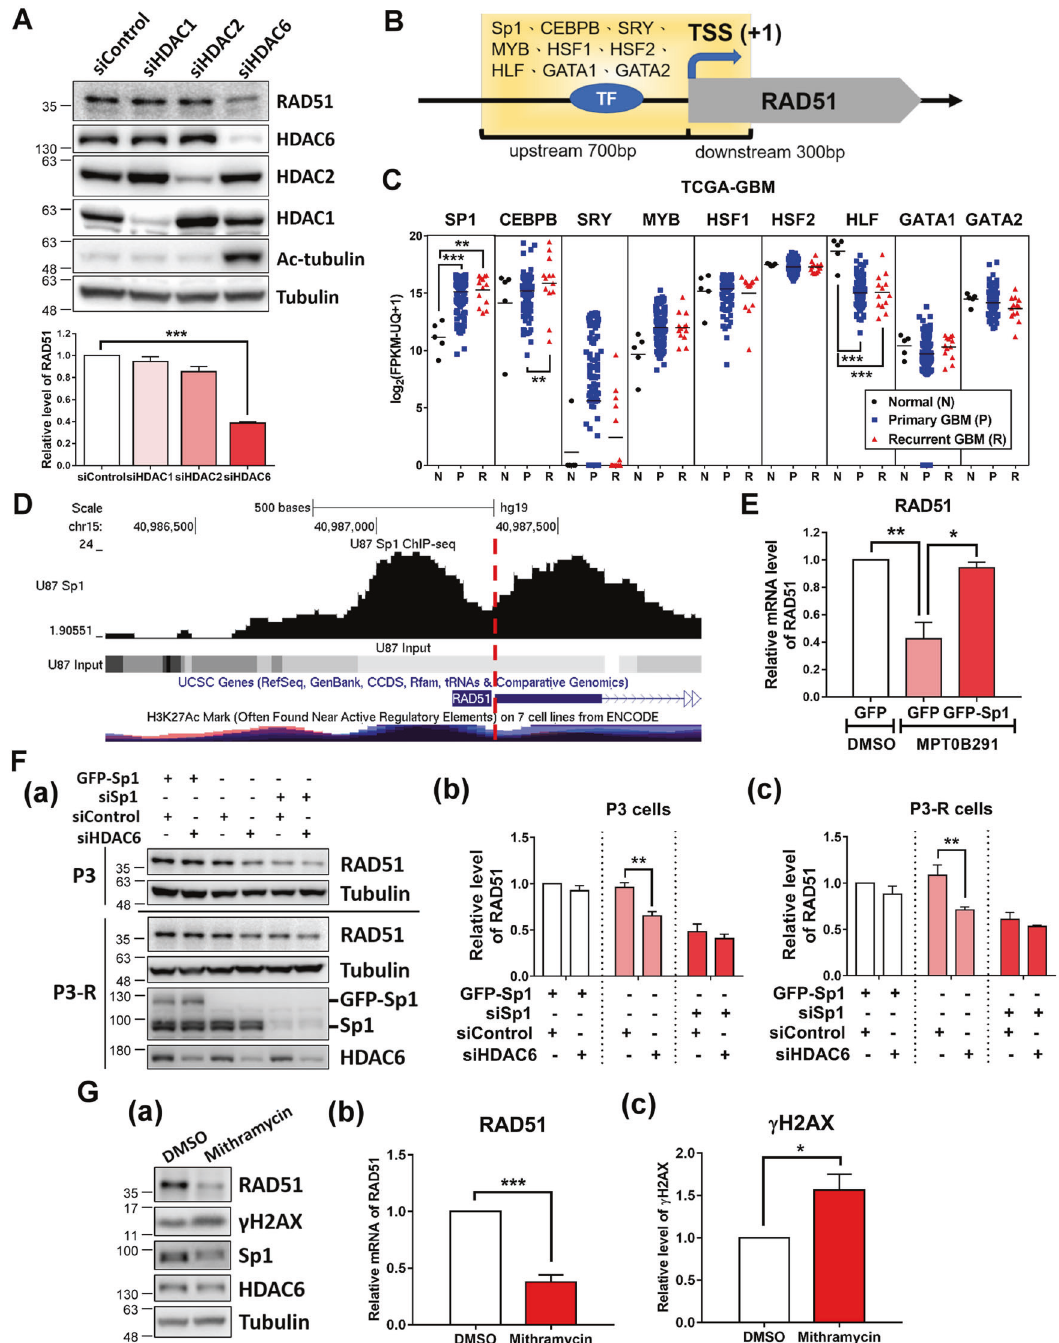
Fig. 5 HDAC6 regulates RAD51 expression through Sp1. A U87MG cells were transfected with control, HDAC1, HDAC2, and HDAC6 siRNA, respectively, for 72 h. The protein levels of RAD51, HDAC1, HDAC2, HDAC6, Ac-tubulin, and tubulin were analyzed by western blotting (upper panels). Result of the quantitative analysis (normalized to tubulin) of RAD51 from three independent experiments is shown (lower panel). B Schematic diagram shows the promoter region used for transcription factor-binding analysis. TSS transcription start site. C The mRNA expression levels of SP1, CEBPB, SRY, MYB, HSF1, HSF2, HLF, GATA1, and GATA2 in normal brain, primary, and recurrent tumor samples (TCGA- GBM dataset). D Distributions of Sp1-ChIP-seq reads mapped to the promoter region of RAD51. Visualization of the Sp1-ChIP-Seq data using the UCSC Genome Browser on Human (hg19) Assembly (https://genome.ucsc.edu/). The red dash line indicates TSS. E U87MG cells were treated with DMSO or 10 μ M MPT0B291 following transfection with GFP or GFP-Sp1 plasmid. On the next day of treatment, the mRNA expression of RAD51 in cells was analyzed using qPCR. Quantitative result (normalized to GAPDH) from three independent experiments is shown. F P3 and P3-R cells were transfected with GFP-Sp1, siSp1, siControl, and siHDAC6, respectively, for 72 h. The protein levels of RAD51, Sp1, HDAC6, and tubulin were analyzed using western blotting (a). Quantitative results (normalized to tubulin) of RAD51 in P3 cells (b) and P3- R cells (c) from three independent experiments are shown. G P3-R cells were treated with 10 μ M mithramycin A for 24 h. The protein levels of RAD51, γ H2AX, Sp1, HDAC6, and tubulin were analyzed by western blotting (a). Quantitative results (normalized to tubulin) of RAD51 (b) and γ H2AX (c) from three independent experiments are